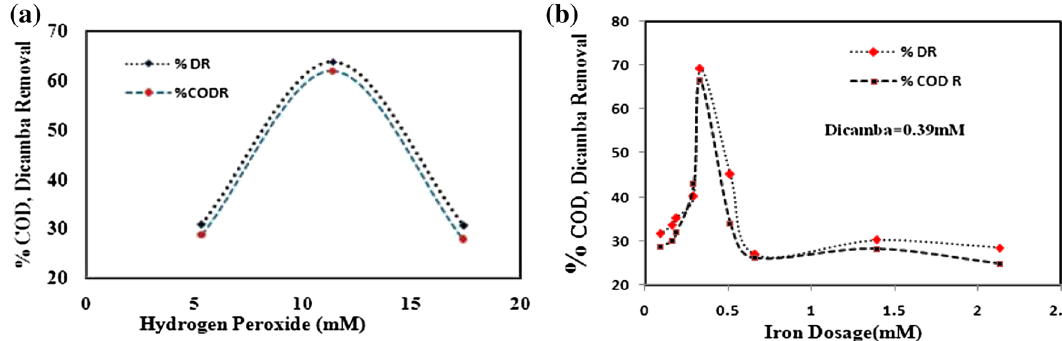
Fig. 2 a Effect of H 2 O 2 on % COD and dicamba removal efficiency. b Effect of Fe 2 ? on % COD and dicamba removal efficiency